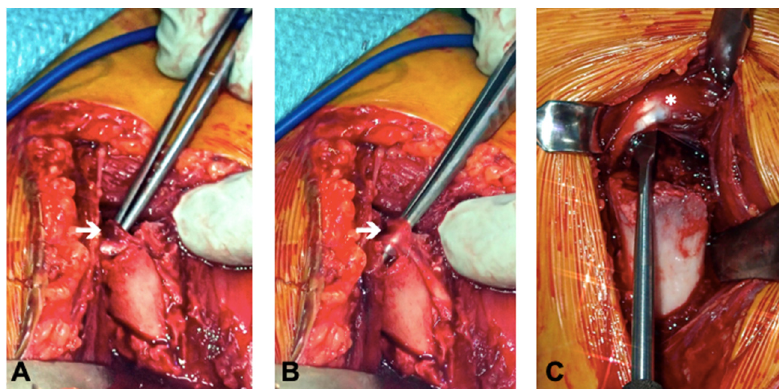
Figure 3. Intraoperative findings. ( A ) Entrapment of the long biceps tendon (white arrow) in the fracture gap (Pat. N° 1, see also Figure 2); ( B ) freed long biceps tendon (Pat. N° 1, see also Figure 2);